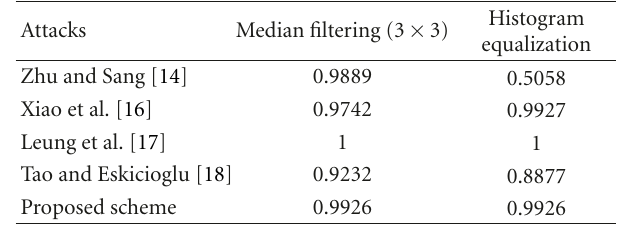
Table 10: Experiment results comparison under median filtering and histogram equalization (NC